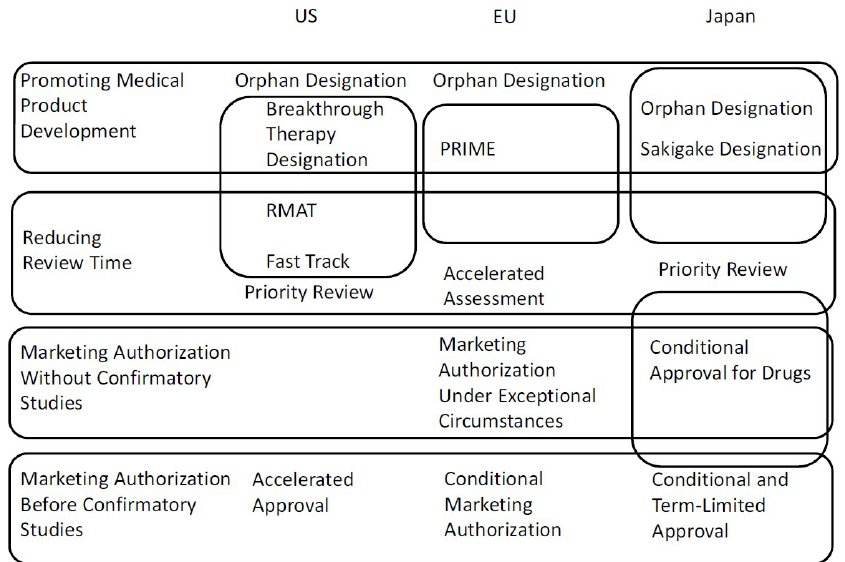
Figure 1. Summary of all procedures discussed in this article.